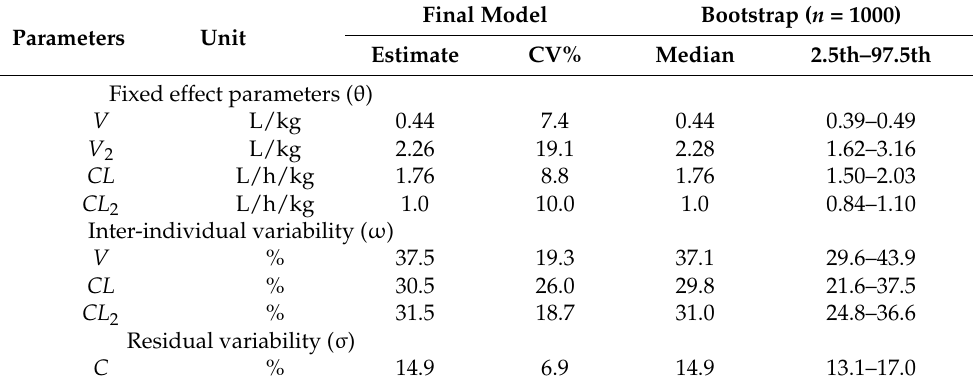
Table 3. Population pharmacokinetic parameters of oxaliplatin (L-OHP) in normal, mild, and severe renal failure model rats.